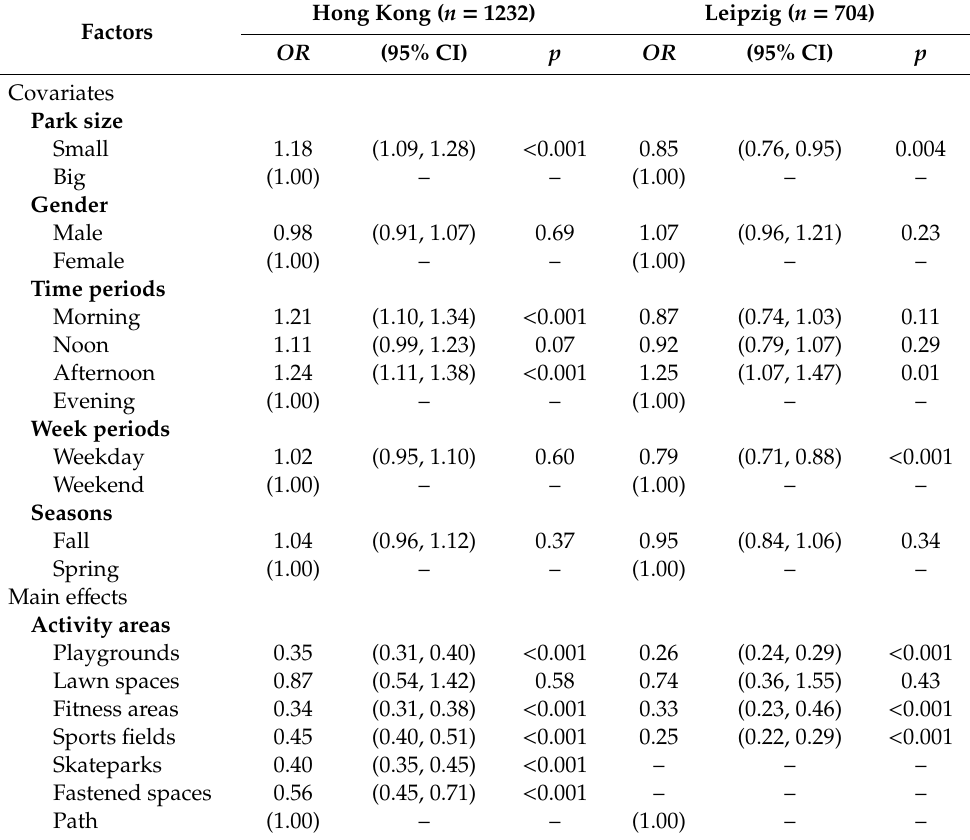
Table 2. Results of negative binominal regression analyses assessing the associations between number of older adults observed being active in parks and the types of activity